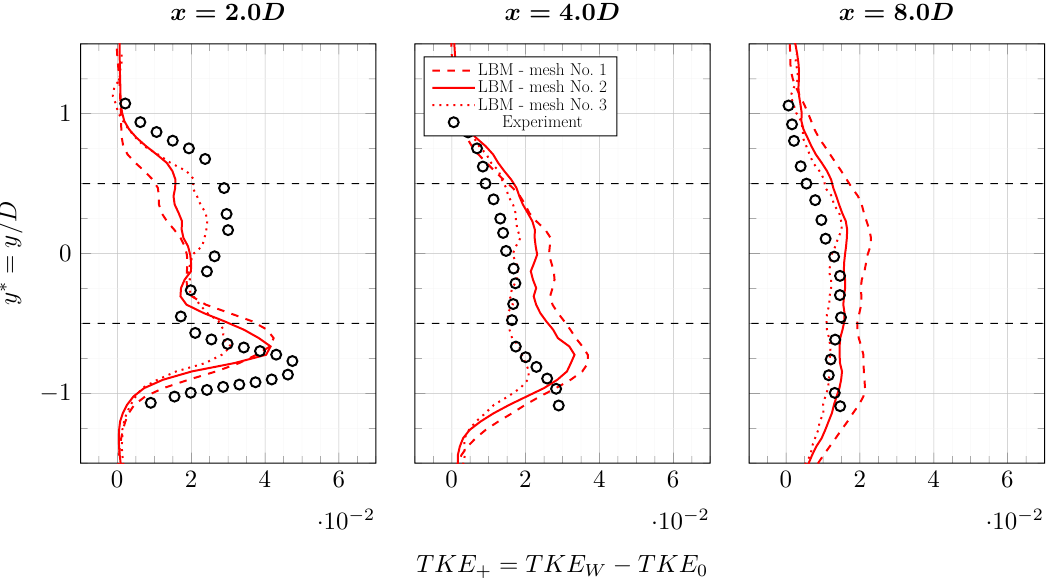
Figure 9. Average axial TKE y profiles in the wake of the tidal turbine [27] at TSR = 1.1: experimental data and ALM-LBM results for the three meshes. Turbine footprint is drawn in horizontal black dashed-lines.